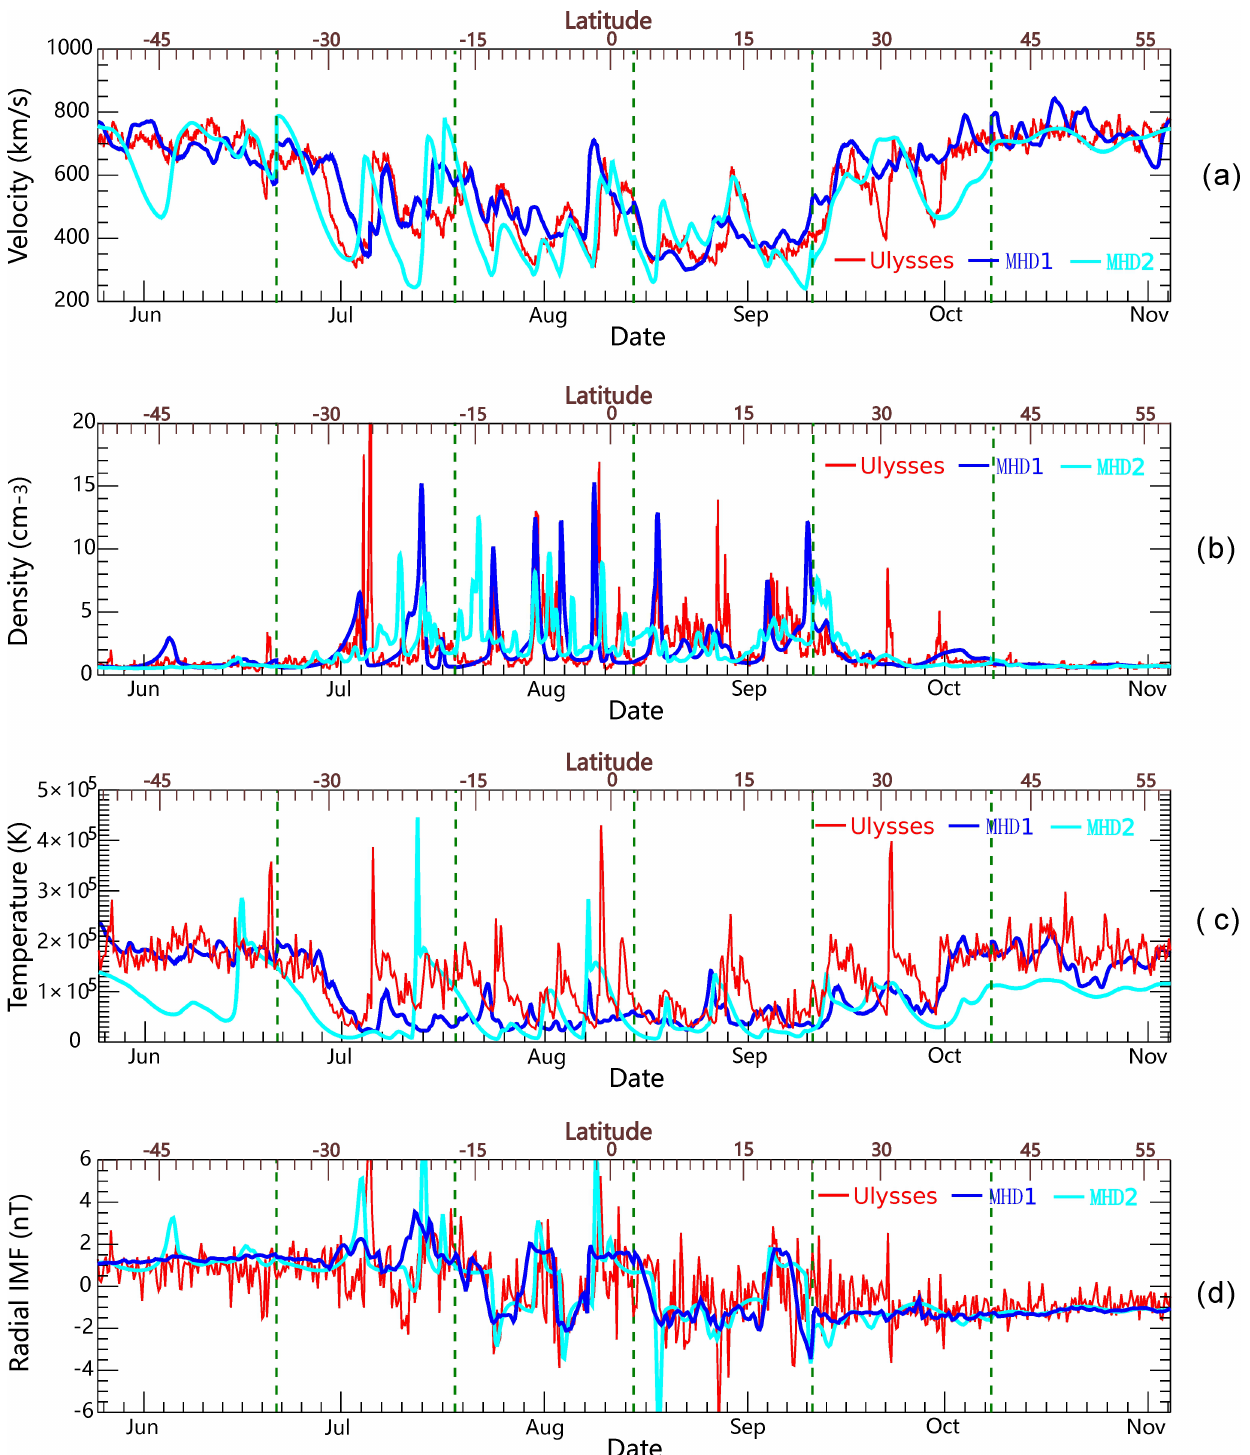
Figure 8. Comparison of the MHD modeled solar wind ( a ) velocity, ( b ) density, ( c ) temperature and ( d ) radial IMF with the in situ observation at the Ulysses trajectory during CR2057 to CR2062, where MHD1 is the new model driven by multiple observations and ANN, and MHD2 is our previous MHD